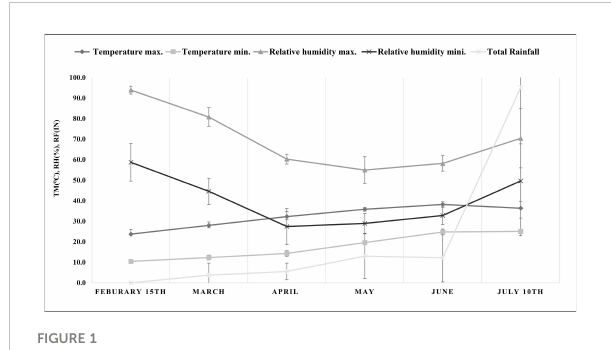
FIGURE 1 Meteorological data on maximum and minimum temperature (°C), maximum and minimum relative humidity (%) and total rainfall (in) during the experiment (from plant transplantation to harvesting). TM, temperature; RH, relative humidity; RF,